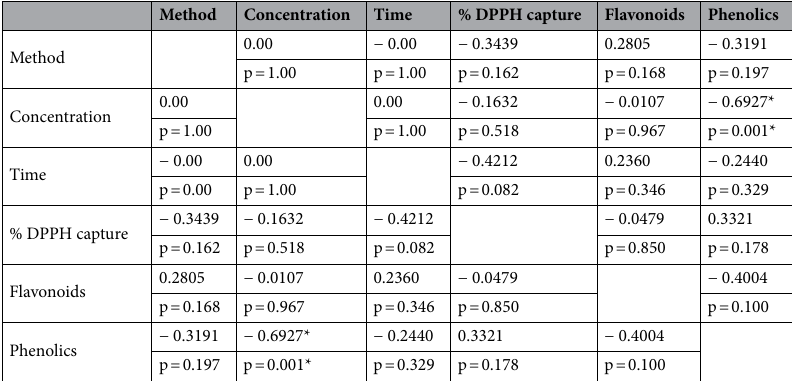
Table 8. Pearson correlation for the hexane extract. *Results statistically significant.